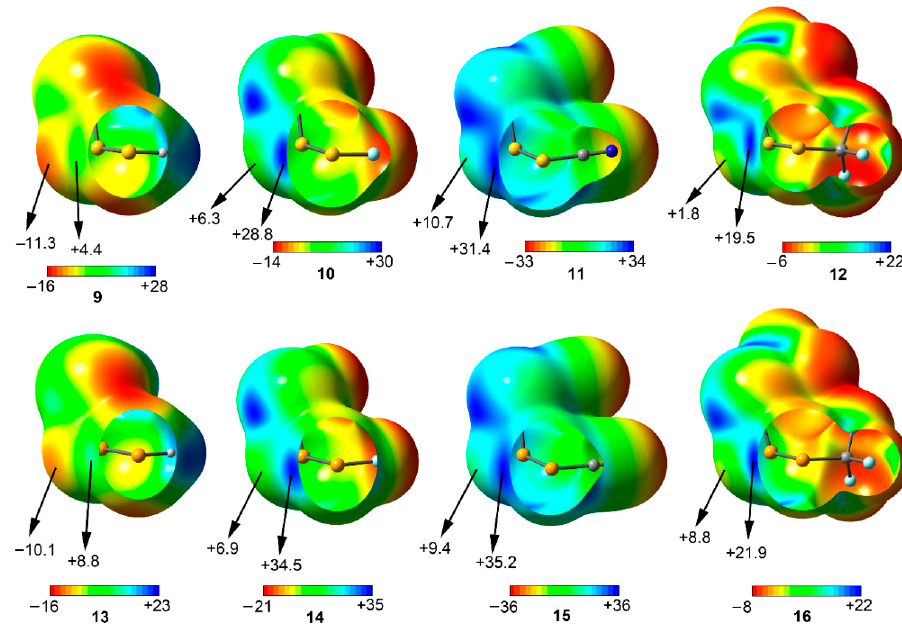
Figure 4. MEP surfaces of compounds 9 to 16 used in the study. Energies at selected points of the surface (0.001 a.u.) are given in kcal/mol.